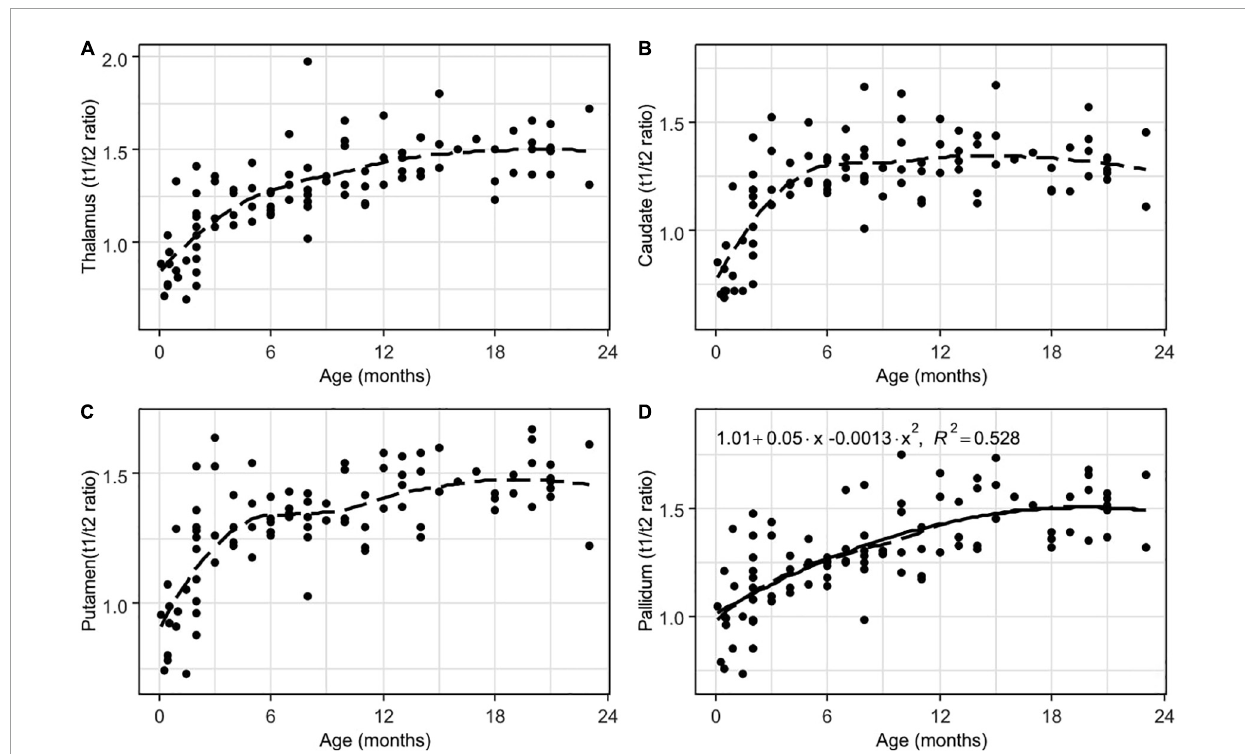
FIGURE6 Results of LOESS and 2nd order polynomial regression analyses between subjects’ age (in months) as the predictor variable and the T1w/T2w ratio values as the response variable in thalamus (A) , the head of the caudate nucleus (B) , putamen (C) , and pallidum (D) . The dotted line represents the LOESS regression curve, and the solid line represents the 2nd-order polynomial regression curve (adjusted p <